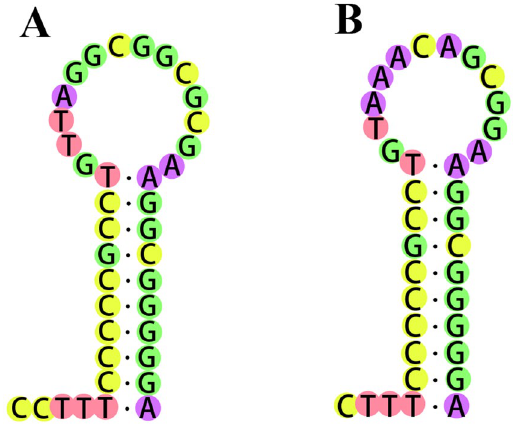
Figure 5. The putative hairpin secondary structure of the O L found in the C. kumu ( A ) and L. microptera ( B )